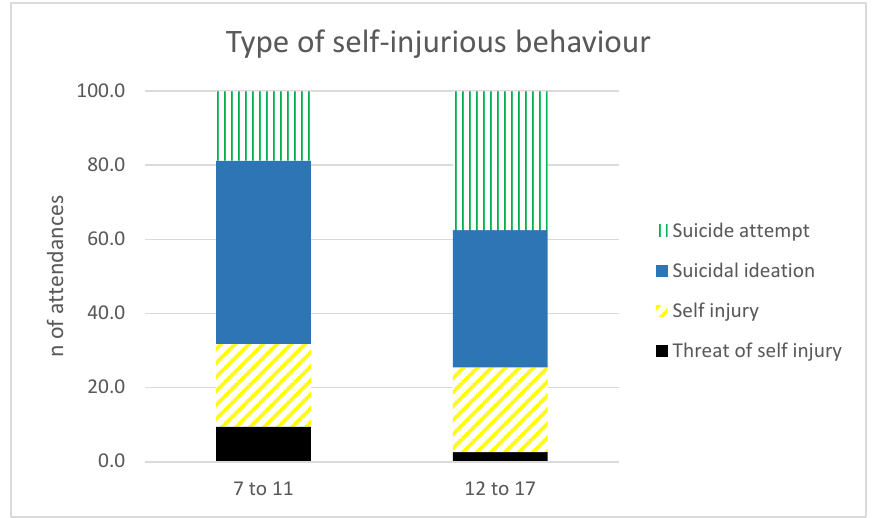
Figure 6. Ambulance attendances as a function of self-injurious behaviour. Threat of self-injury and suicidal ideation are more common in the 7–11 age group, with suicide attempts more common in